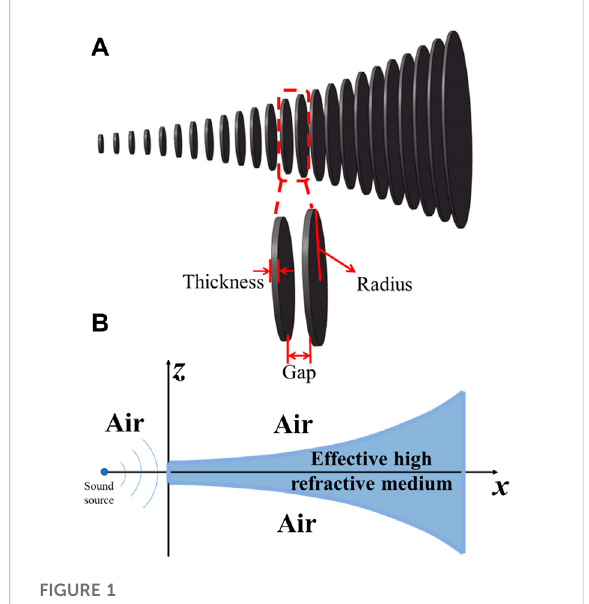
FIGURE 1 (A) Schematicoftrumpet-shapedacousticmetamaterials; (B) 2D effective medium schematic.